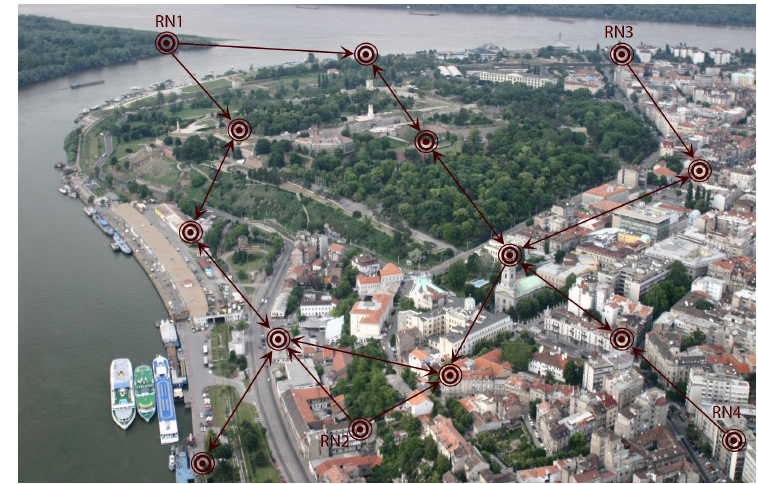
Figure 2. An example sensor network used in smart-city applications with multiple (four) reference nodes. The reference nodes (RNs) have fixed calibration parameters: only the rest of the nodes implement the given distributed sensor calibration